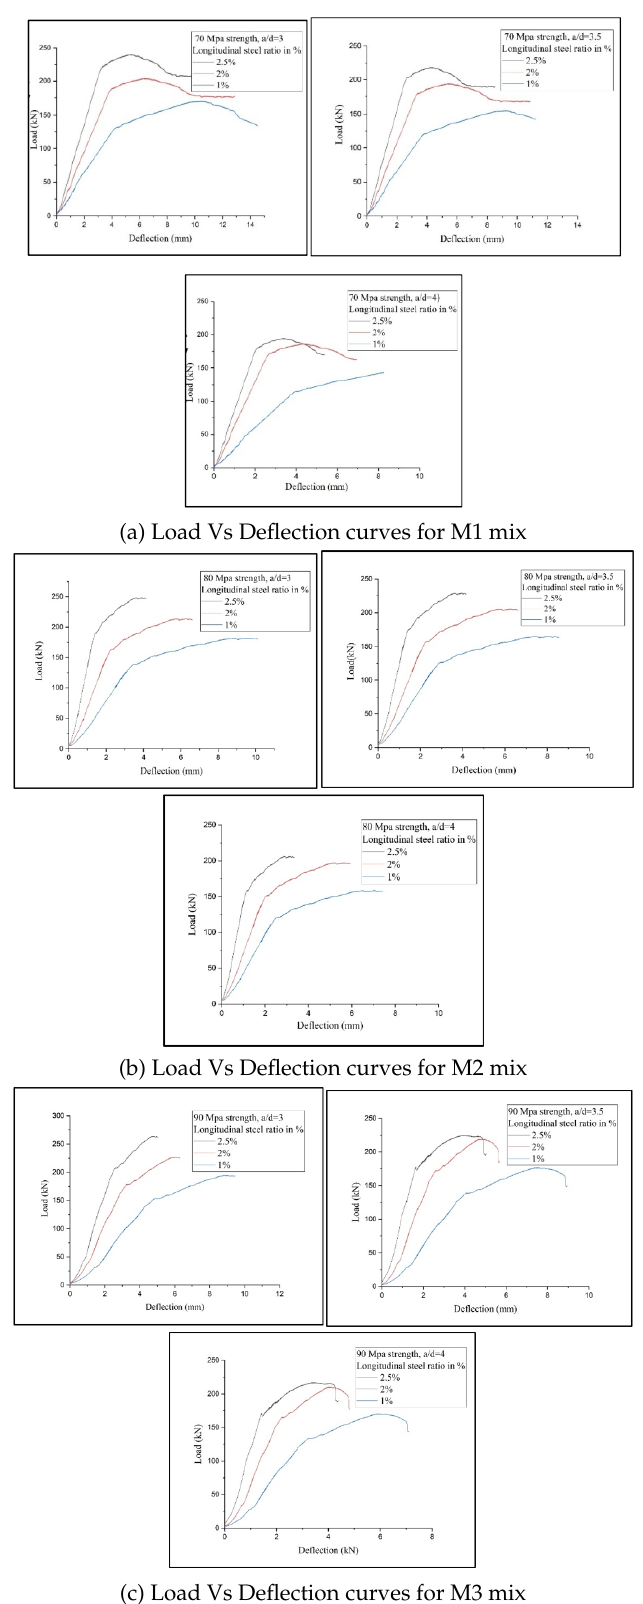
Fig. 5. Effect of shear span to depth (a/d)